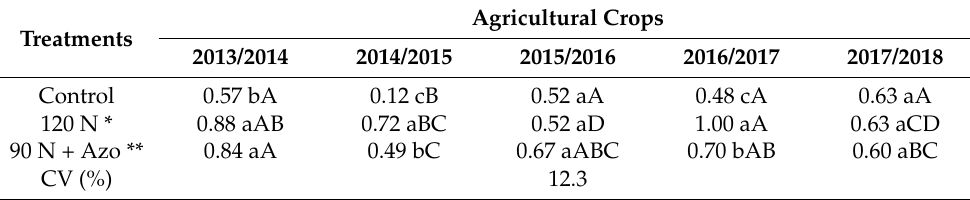
Table 7. Amount of nitrogen accumulated in the area of rice plants (%) as a function of treatments with and without nitrogen and combined with Azospirillum brasilense . Average of four repetitions. Crops